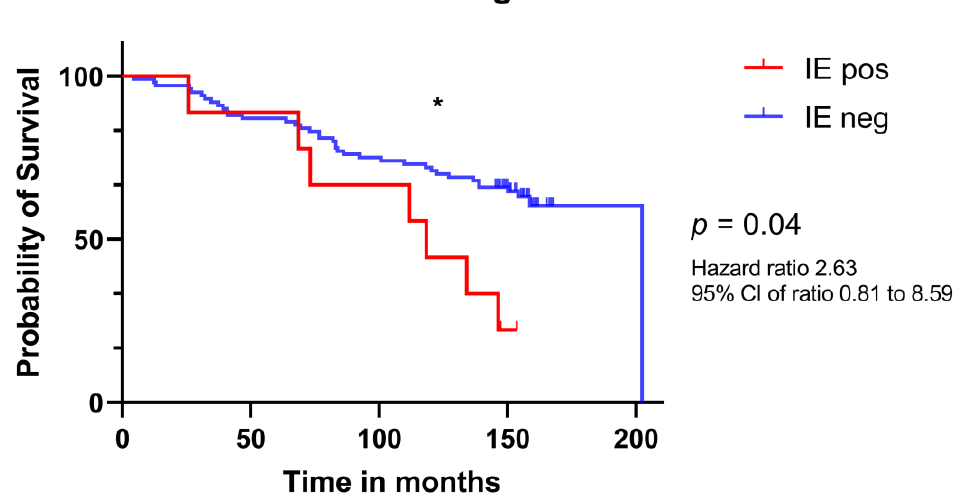
Figure 2. Kaplan–Meier estimates of overall survival in patients with breast cancer according to HCMV IE status at time of diagnosis. Estimated survival time for 9 patients whose tumors were IE positive (red) and of 100 patients whose tumors were IE negative (blue). Significance is indicated as following: * ( p < 0.05).